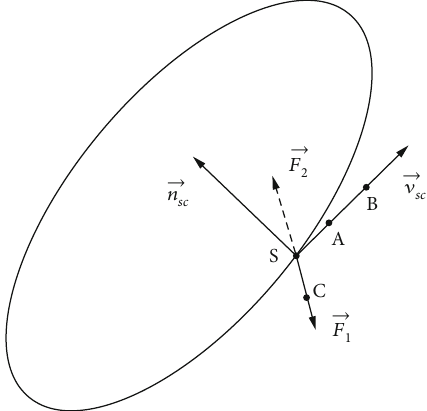
Figure 4: Diagram of the selection of the unit vector direction of the thrust